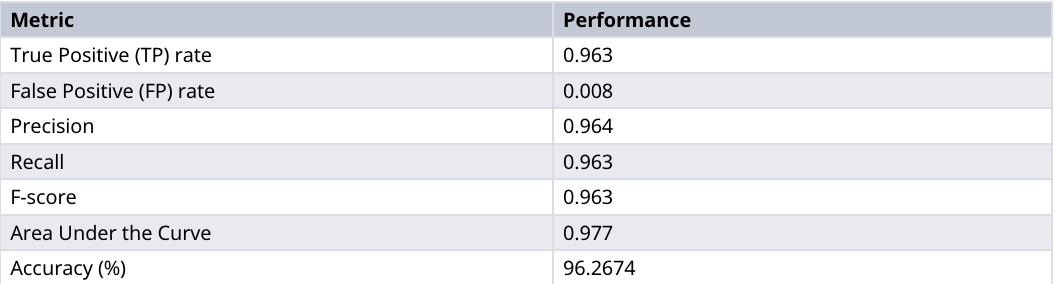
Table 2. Performance of Stacked Discriminant Feature Learning